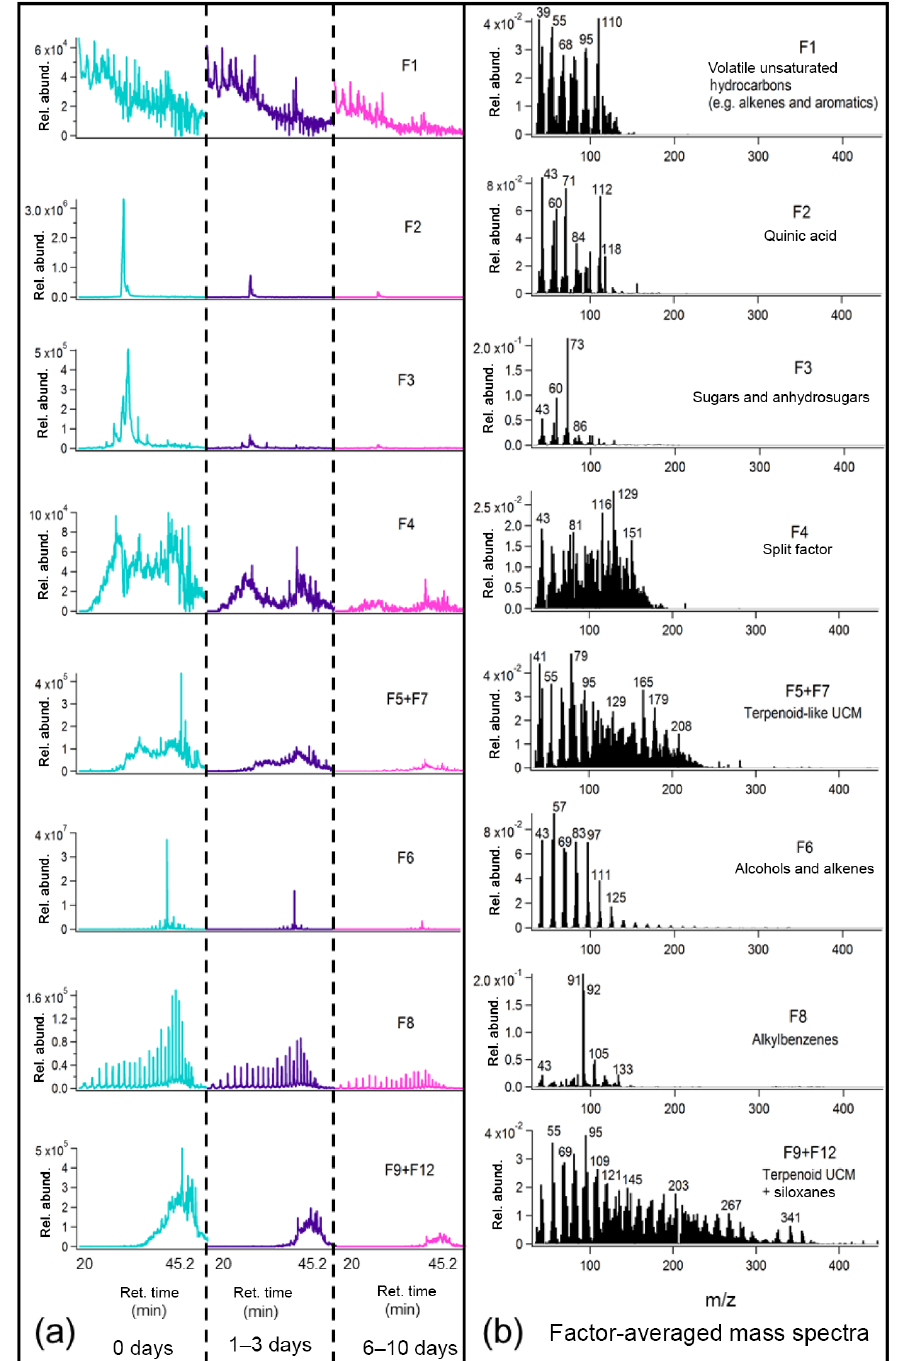
wood BBOA, respectively) from unaged chromatograms to 6–10 days of aging. Although the column bleed decreases with photochemical aging in both cases, this trend is due to differences in blank subtractions from run to run and is not related to changes in photochemical